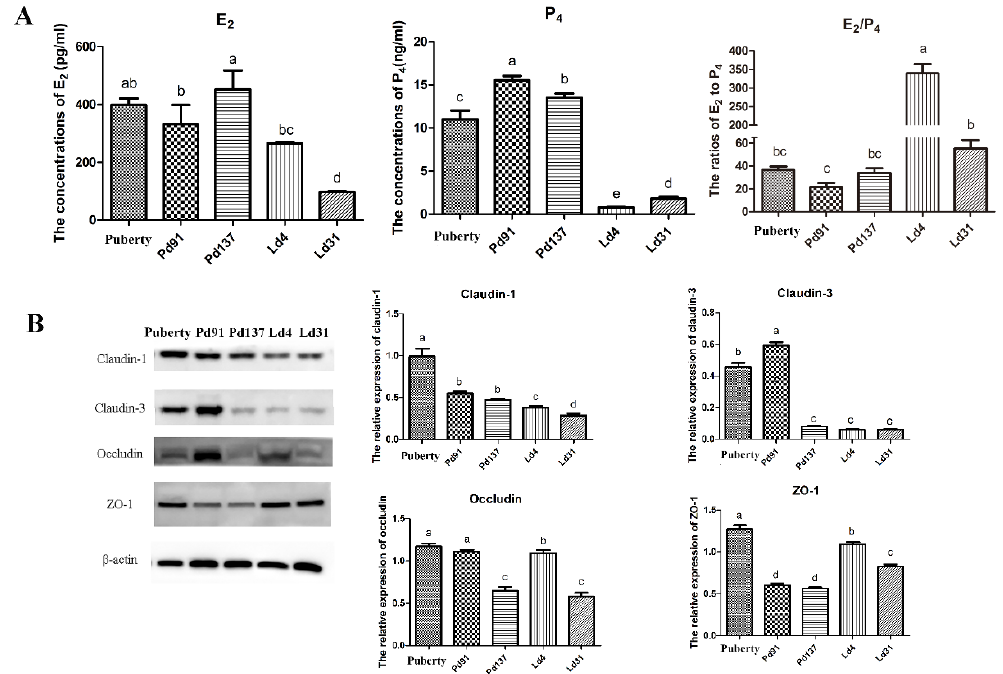
Figure 1. The serum E 2 and P 4 levels and the protein expression of the TJ proteins of goats at the stages of 8 m, Pd91, Pd137, Ld4, and Ld31. ( A ) Serum E 2 and P 4 levels and the ratios of E 2 to P 4 . ( B ) The protein expression of claudin-1, claudin-3, occludin, and ZO-1 in goat mammary glands. Data are presented as the means ± SD, different letters indicate the hormones are different ( p < 0.05).